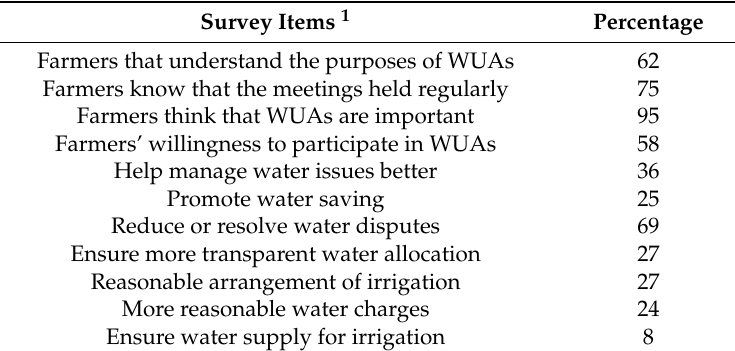
Table 3. Quantification of small-scale farmers’ perceptions of WUAs.